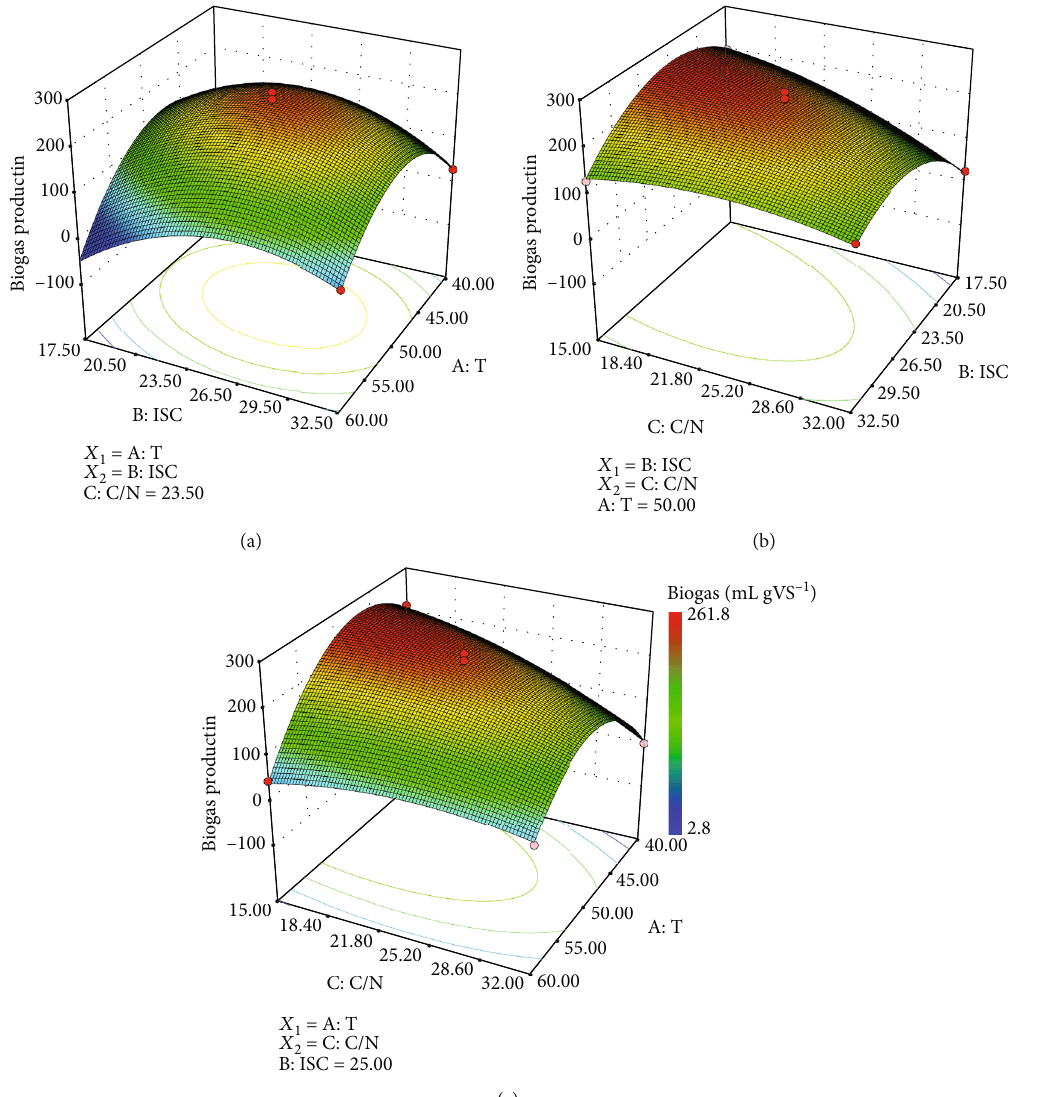
Figure 2: E ff ects of the ISC, T, and C/N ratio on biogas production. (a) Interactive e ff ect of the ISC and T at a C/N ratio of 23.5. (b) Interactive e ff ect of the ISC and C/N ratio at 50 ° C. (c) Interactive e ff ect of the T and C/N ratio at an ISC of